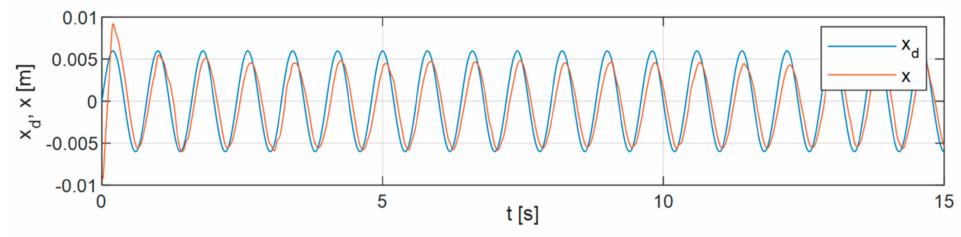
Figure 17. Set x d and realized x positions of the passive part as functions of time.